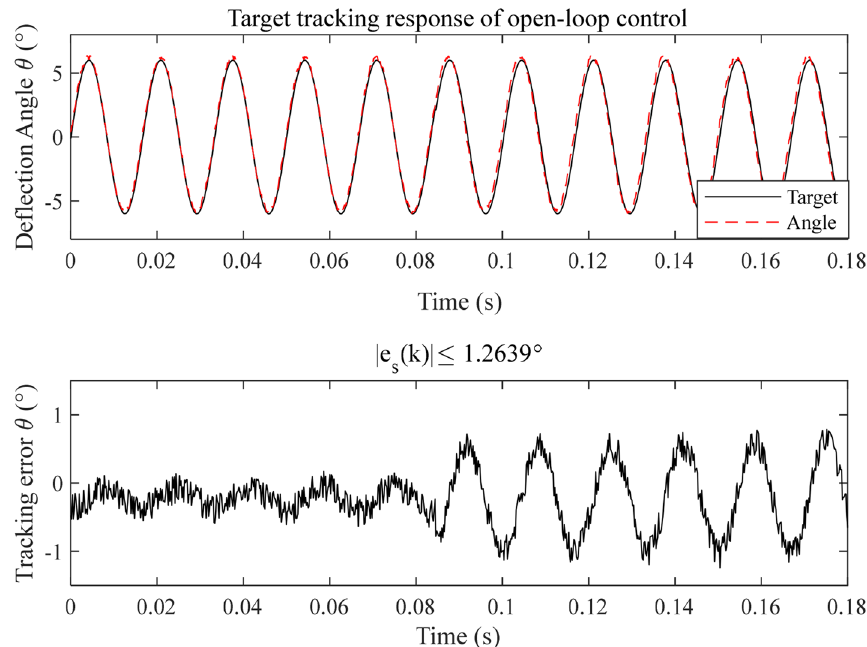
Figure 13. Tracking performance of the open-loop control.